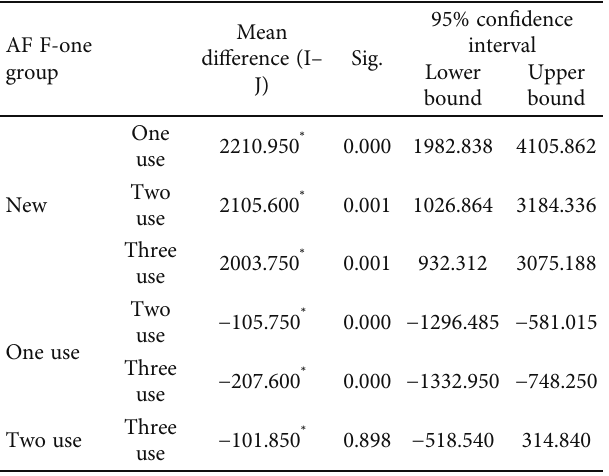
Table 3: Pairwise multiple comparison result for AF F-one